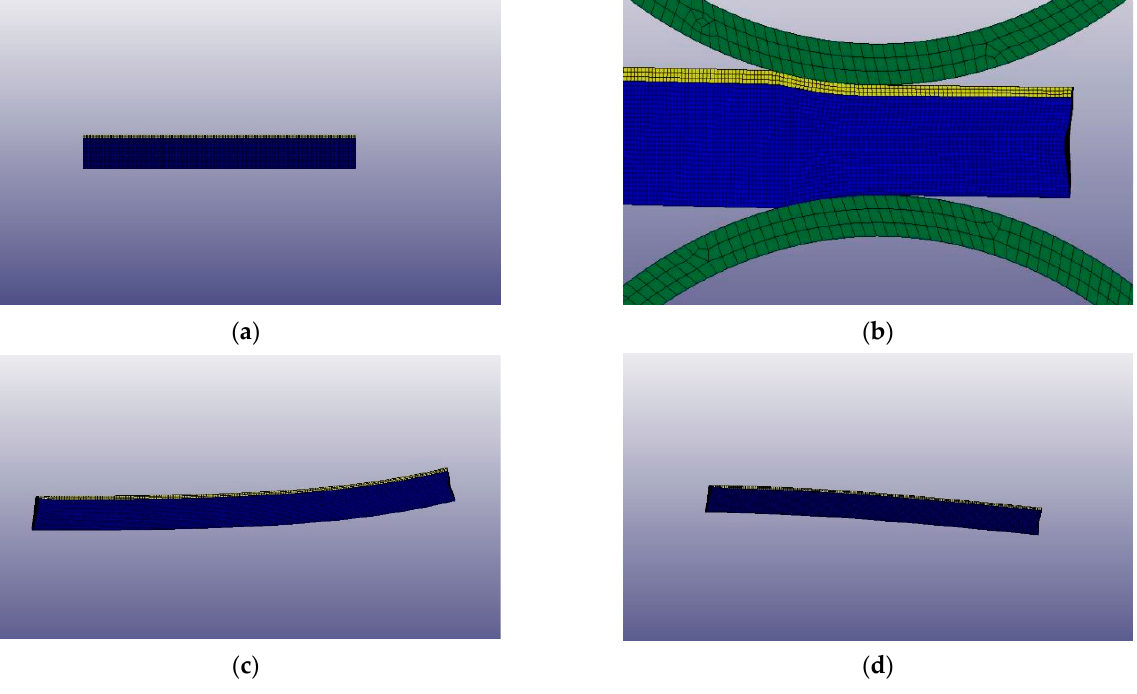
Figure 11. Shape of the clad plate ( a ) before hot rolling, ( b ) during hot rolling, ( c ) during hot rolling with thickness reduction rate of 20%, ( d ) during hot rolling with thickness reduction rate of 25%.